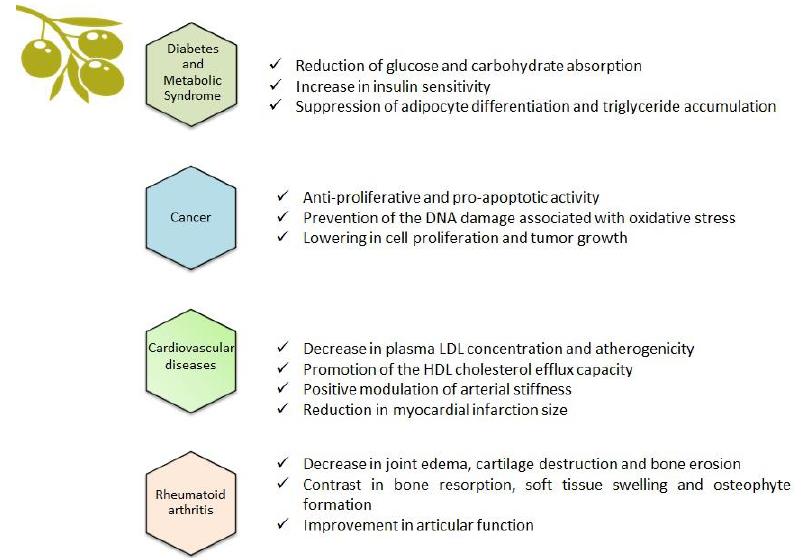
Figure 4. Chronic inflammatory diseases in which olive biophenols showed beneficial properties.